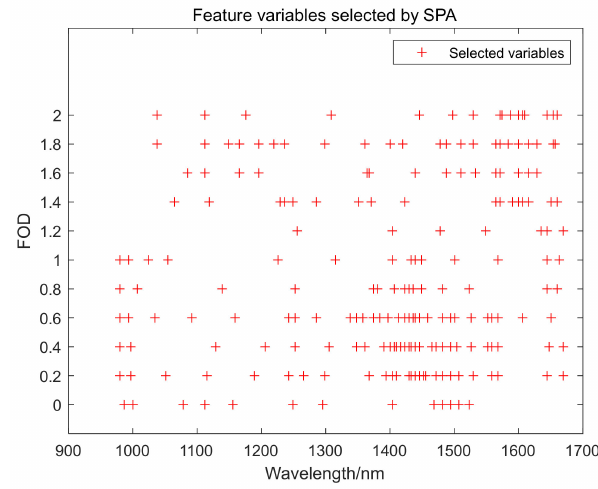
Figure 4. Feature variables selected by SPA under different FOD. Table 2. Comparison of PLSR and SPA-PLSR modeling